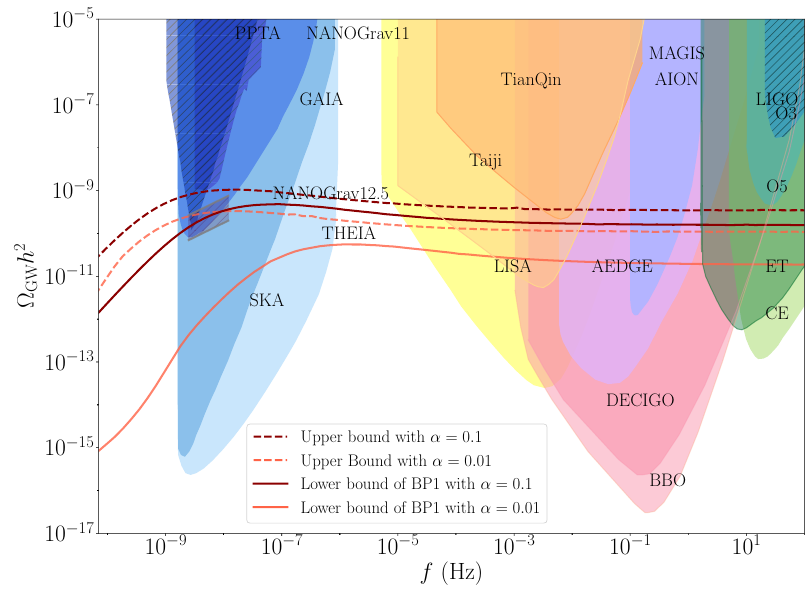
Figure 7 . Gravitational wave spectrum predicted from the model. Breaking of the intermediate symmetry G SU(3) SU(2) SU(2) U(1) generates cosmic strings with tension µ . The 1 ≡ c × L × R × X lower bound to the GW spectrum for the benchmark point we considered earlier (red lines) is Gµ = 2 . 68 × 10 − 11 corresponding to M 1 ’ 2 × 10 13 GeV. The GW spectrums of these two bounds are shown in dashed and solid curves,